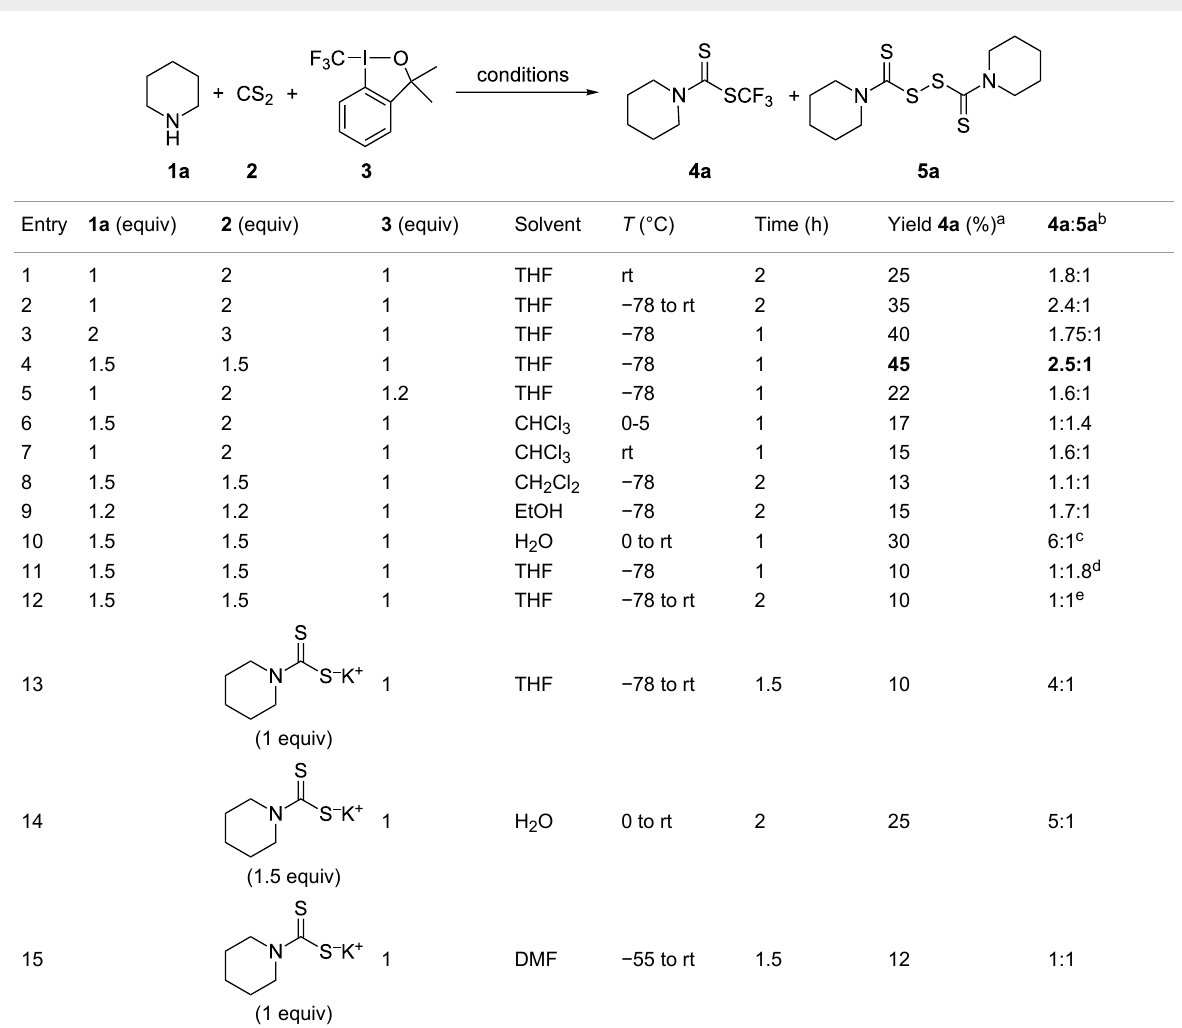
Table 1: Optimization of the reaction